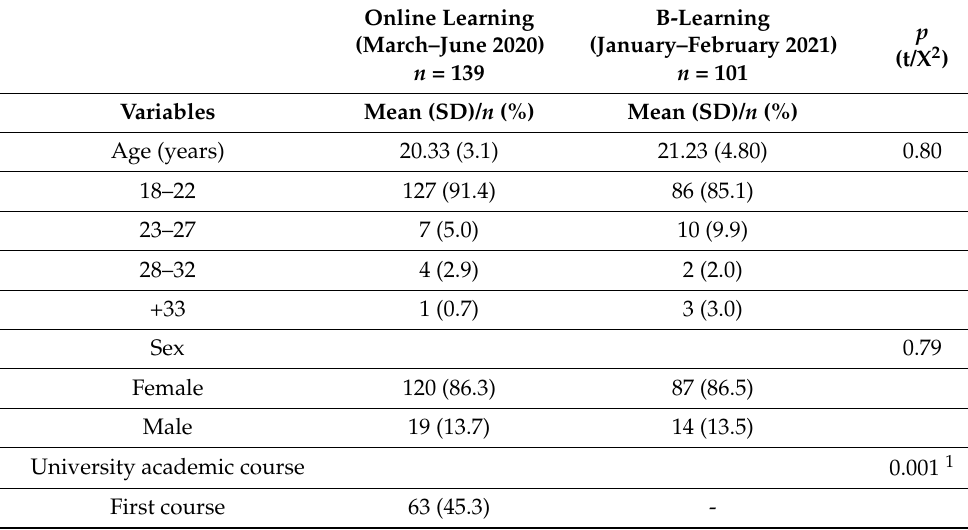
Table 1. Participants’ socio-demographic